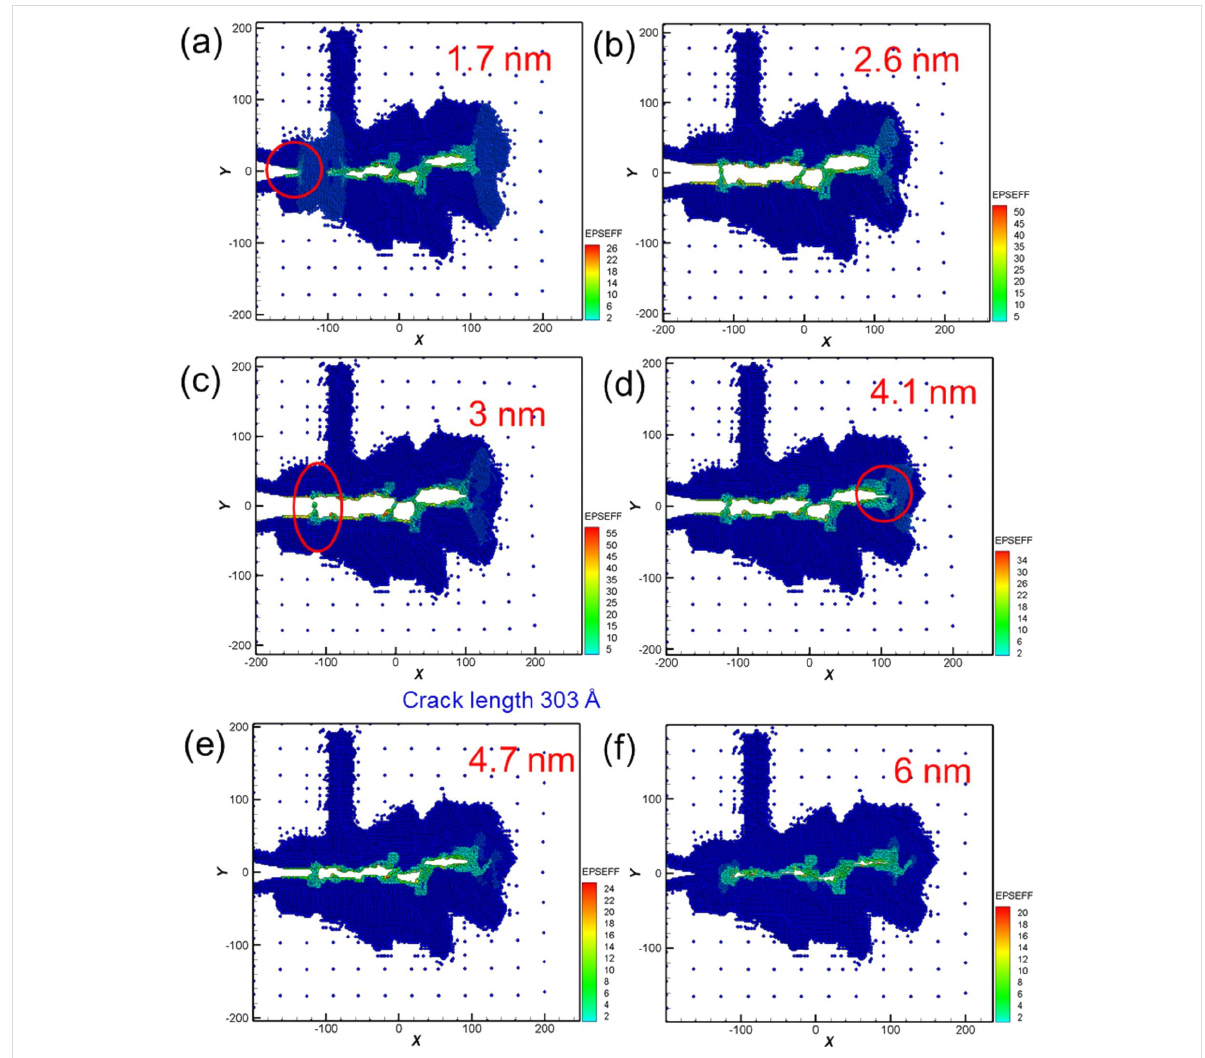
Figure 9: Crack growth and expansion diagrams of Fe under the second cyclic loading at different moving distances. The crack length is 303 Å at a tension distance of 3 nm.